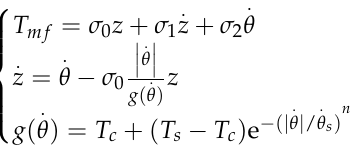
Figure 5. Static parameters identification curve. Table 1. Static parameters of the LuGre model.